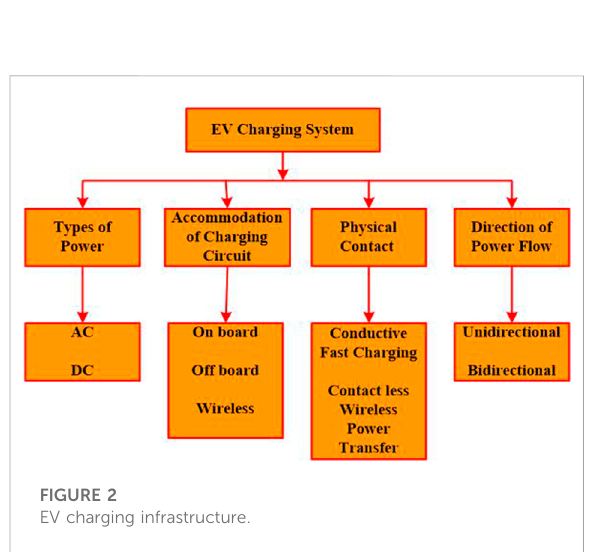
FIGURE 3 Strategic charging network design: An